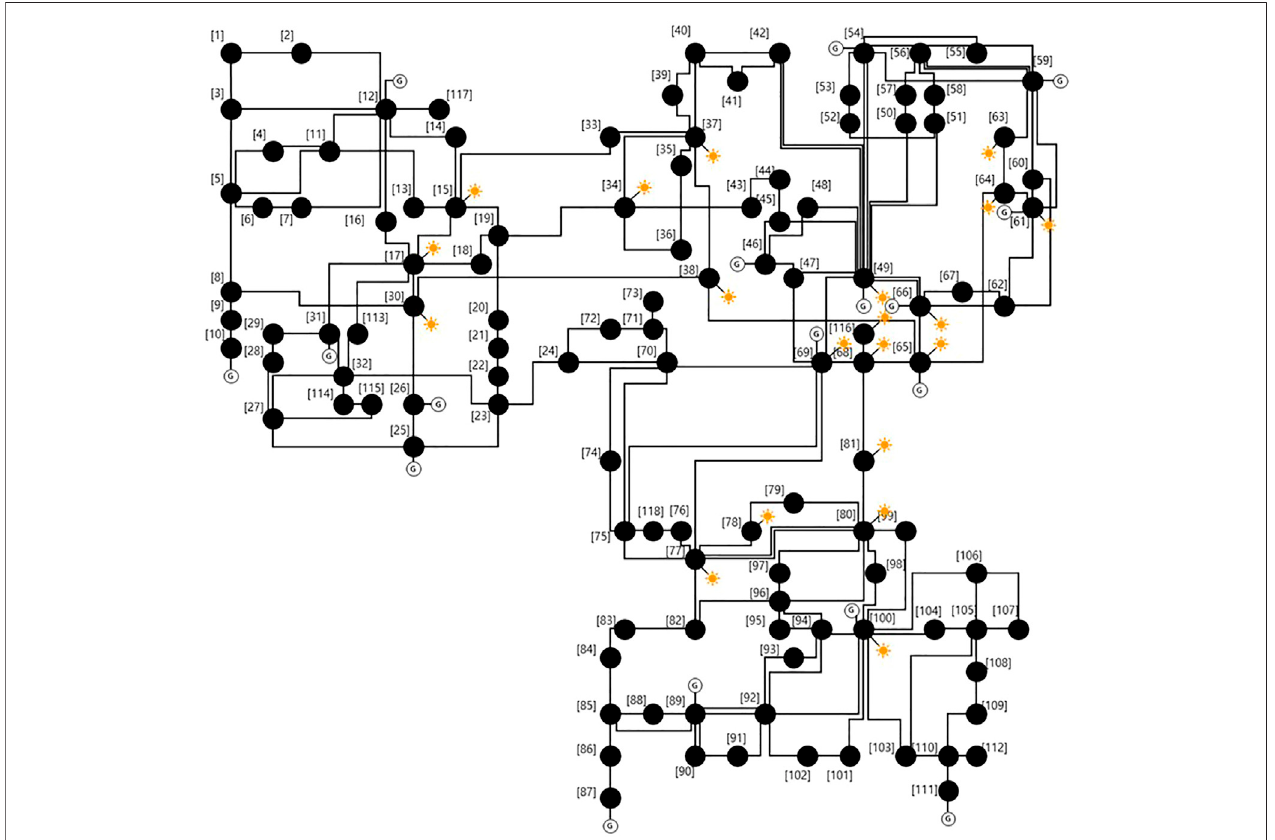
FIGURE 4 | IEEE 118-bus system with photovoltaic (PV)